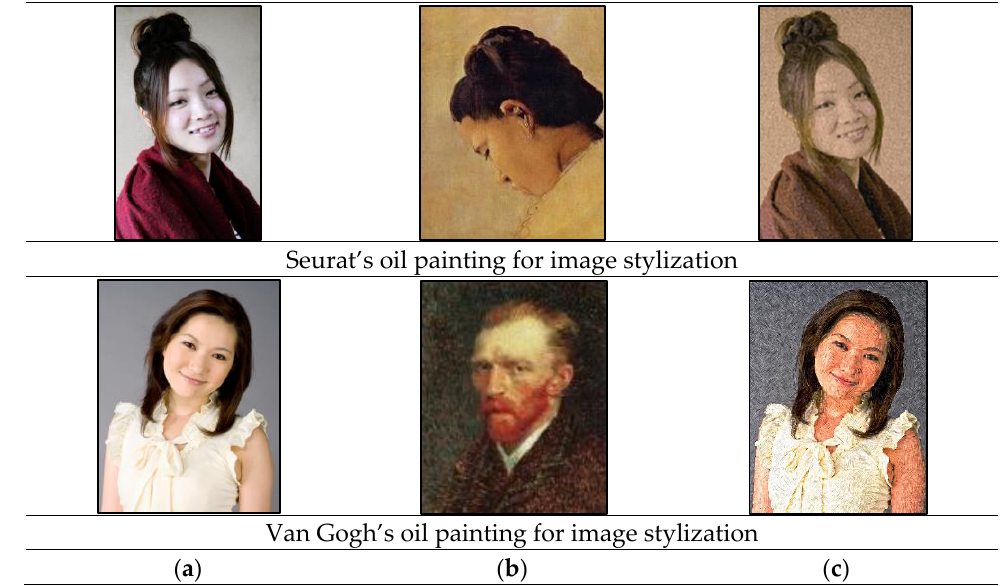
Figure 16. Sample of image stylization: ( a ) portrait image, ( b ) artists’ oil painting, ( c ) stylized image.